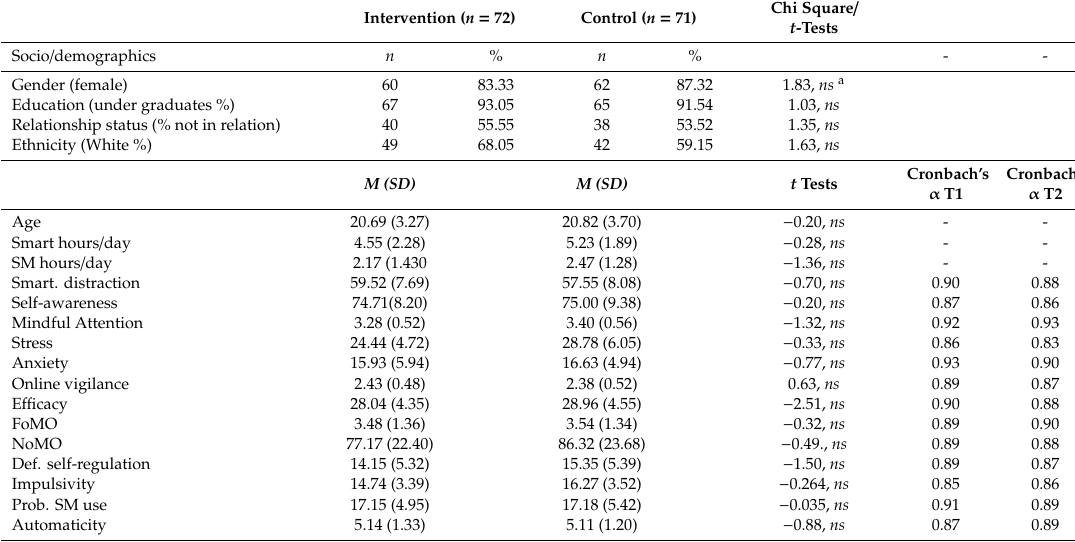
Table 2. Per protocol baseline sociodemographic, usage data, psychological variables and pre-post intervention scale